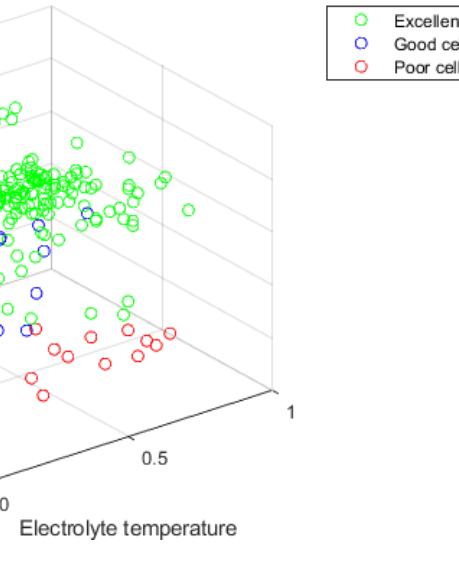
Figure 6. Schematic diagram of cell state clustering effect.